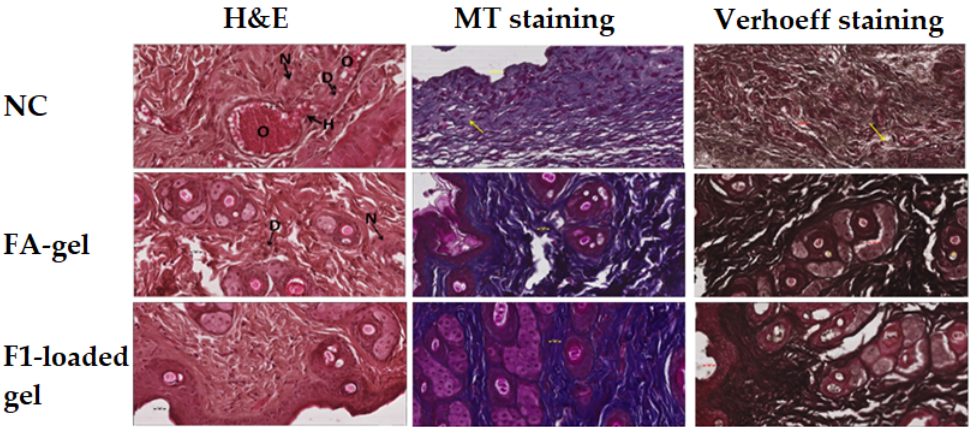
Figure 10. Photomicrographs of skin samples after 21 days treatment with DSM-loaded NE (F1) gel and fusidic acid gel were taken under a microscope using the Hematoxylin and Eosin (H&E), Masson Trichrom (MT), and Verhoeff stains (magnification 400 × , scale bar 20 m). Abbreviations stand for necrosis (N), degeneration (D), occlusion of blood vessel (O), and hemorrhage (H)